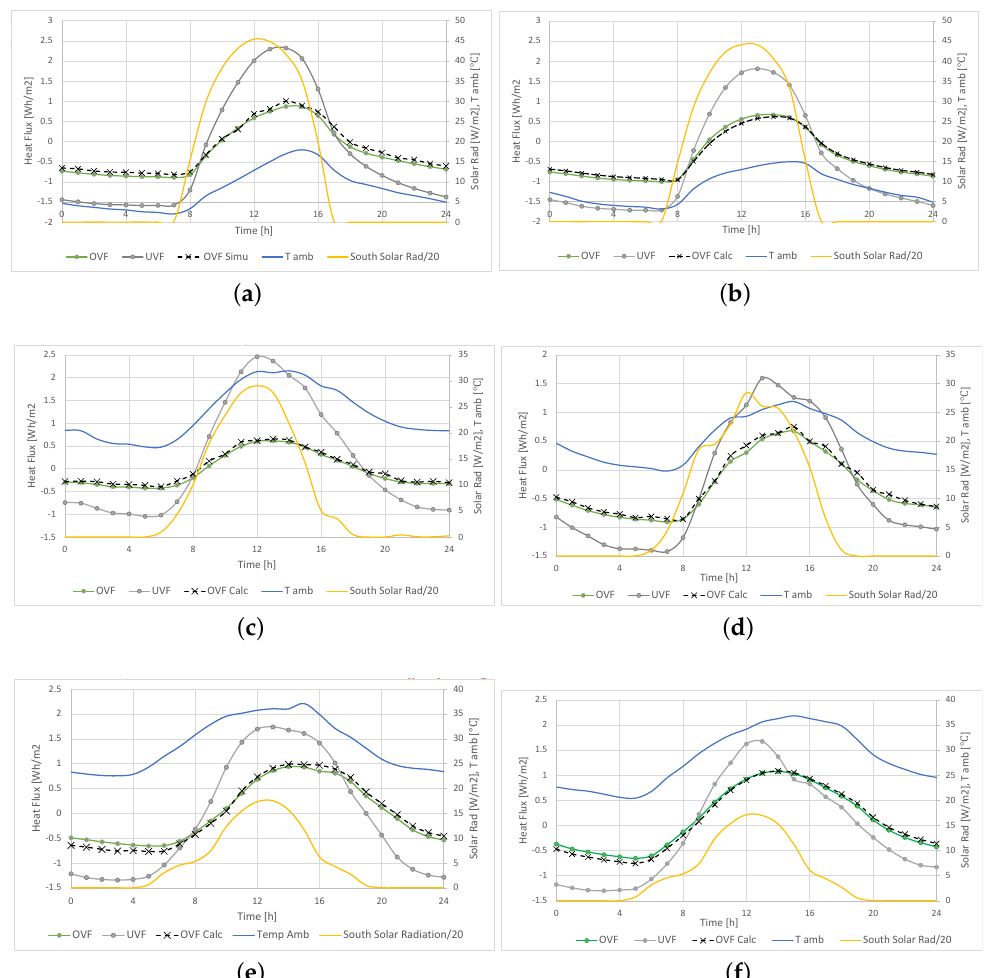
Figure 25. Hourly heat fluxes through the OVF and the UVF for: two days of winter with ( a ) grid open (13 January 2021), ( b ) grid closed (2 January 2021); two days of spring with ( c ) grid open (31 March 2021); ( d ) grid closed (7 April 2021); two days of summer with ( e ) grid open (5 July 2021); ( f ) grid closed (24 June